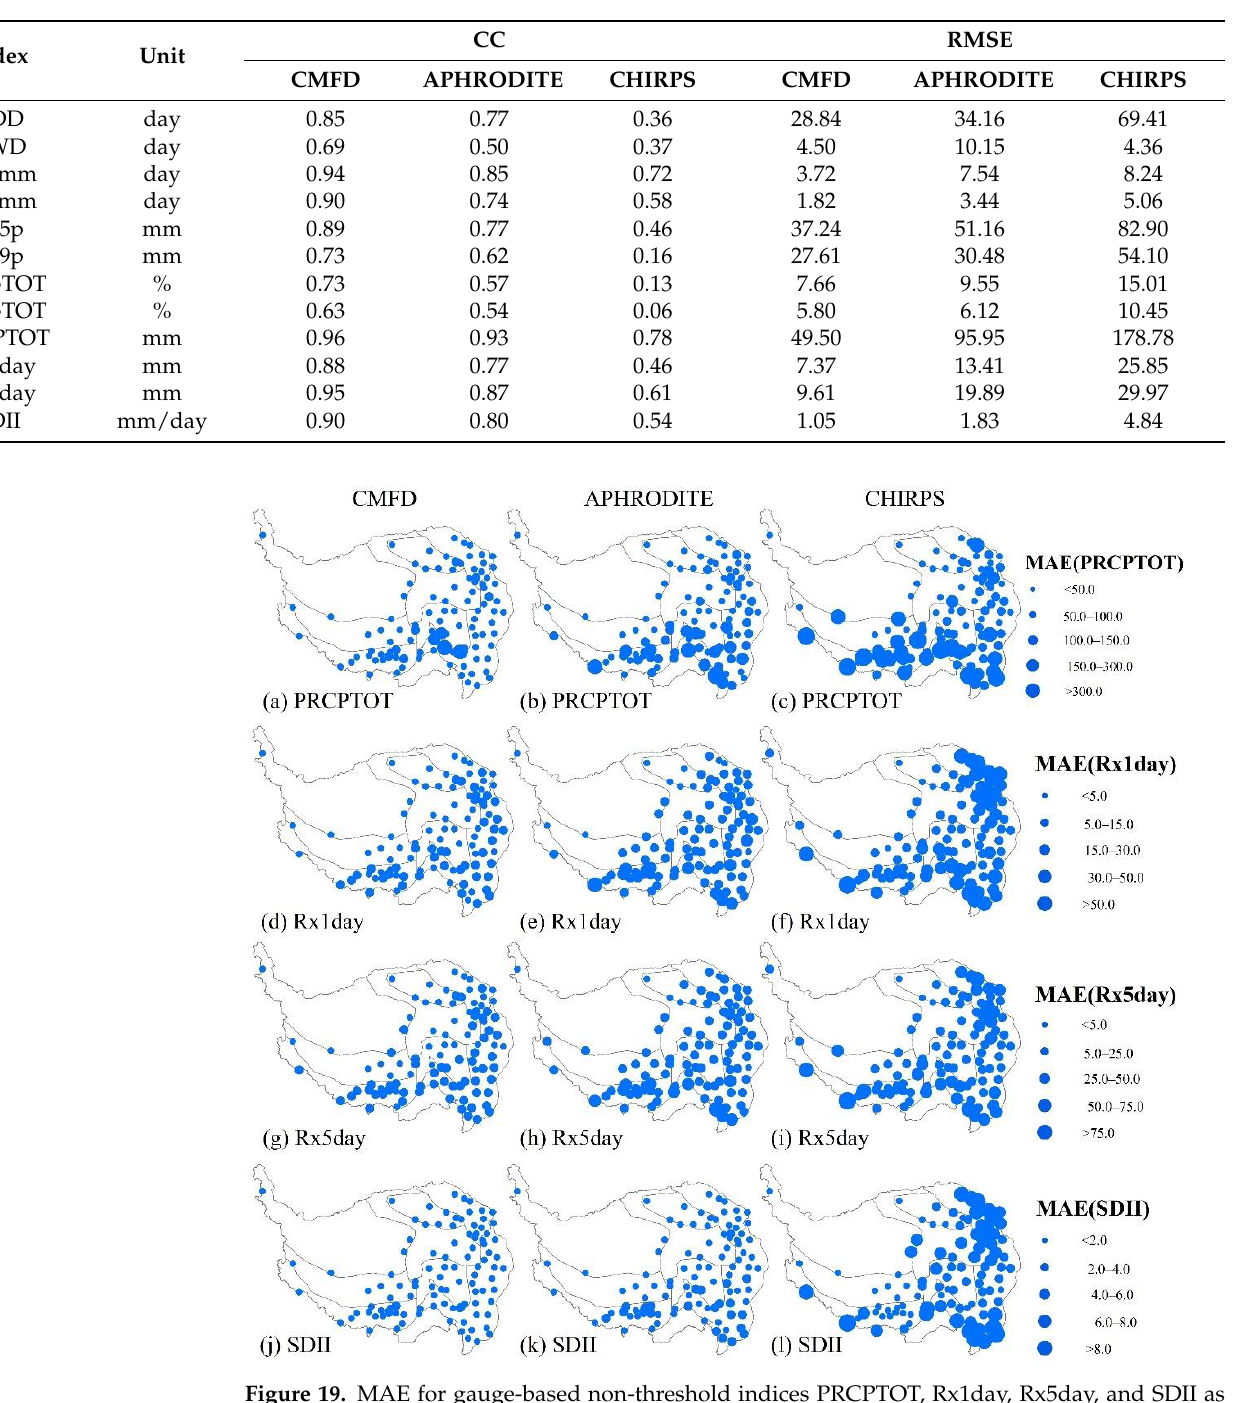
Table 4. Time series of annual extreme rainfall indices based on CMFD, APHRODITE, and CHIRPS. datasets from 1981 to 2014.